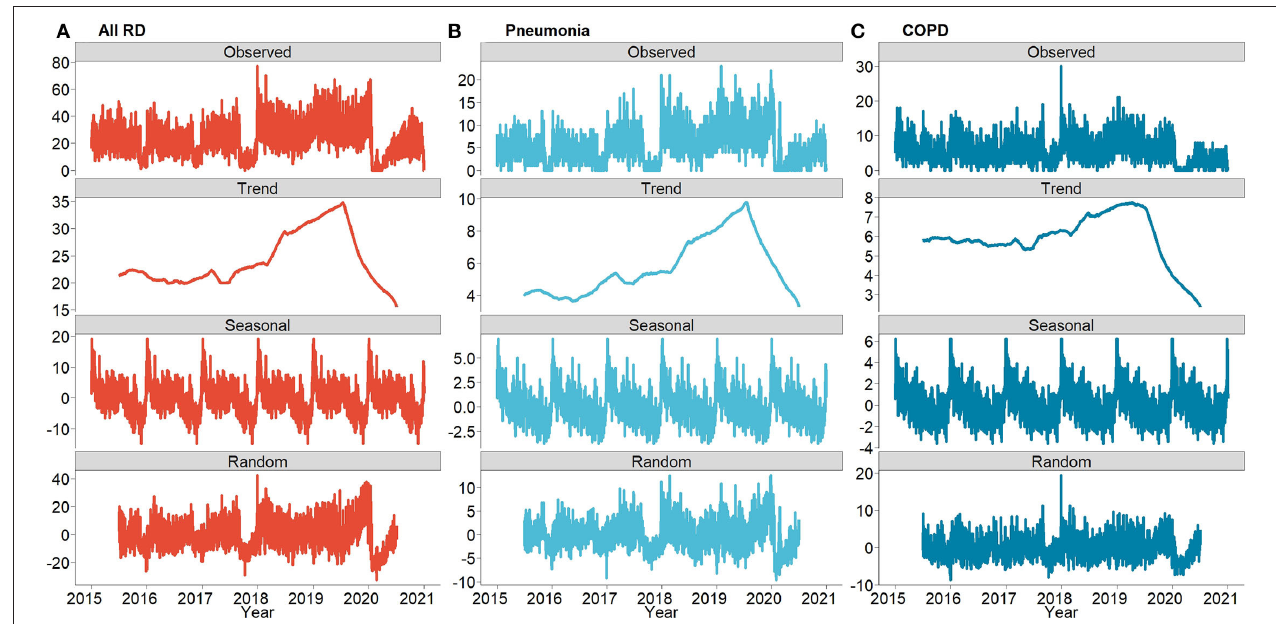
FIGURE 1 | The decomposed distributions for the daily number of hospitalizations due to all RDs, Pneumonia and COPD in Wuhan, China from 2015 to 2020: (A) daily number of hospitalizations of all RDs, (B) daily number of hospitalizations of Pneumonia, and (C) daily number of hospitalizations of COPD.